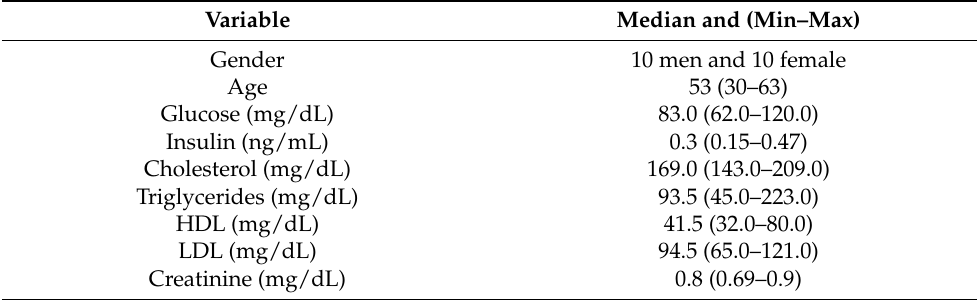
Table 2. Gender, age, and serum biochemical determinations in the healthy